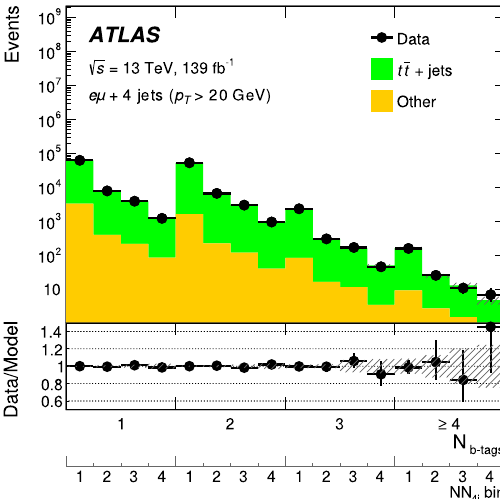
Fig. 4 Observed data and the corresponding background estimation in regions with one electron, one muon, and four jets (left) or five jets (right). All uncertainties, which may be correlated across the bins, are included in the error bands (shaded regions). The shape of the NN tem-